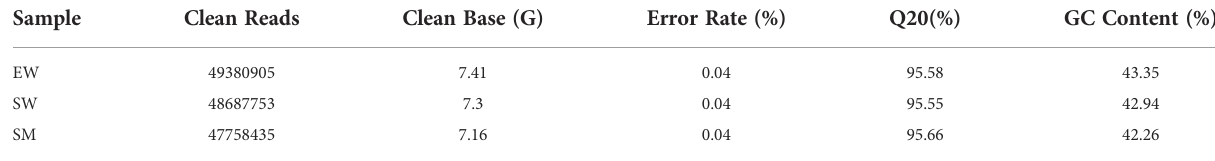
TABLE 1 Summary of sequence